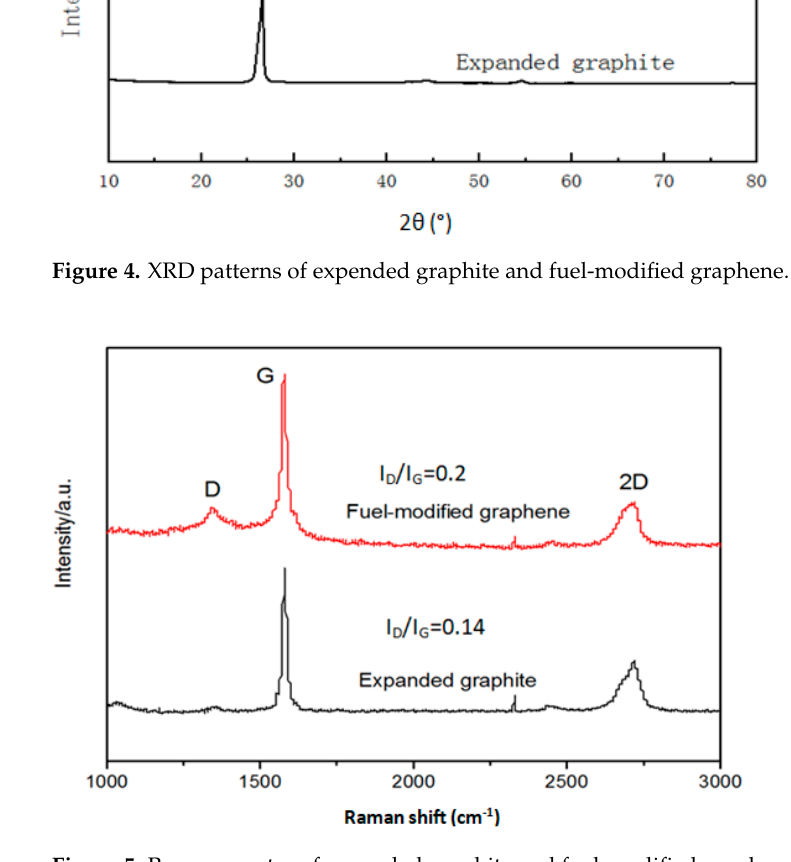
Figure 4. XRD patterns of expended graphite and fuel-modified graphene.